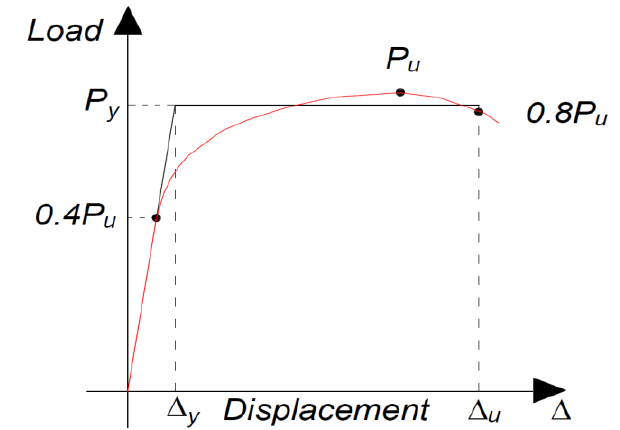
Figure 10. Idealized force-displacement curves.